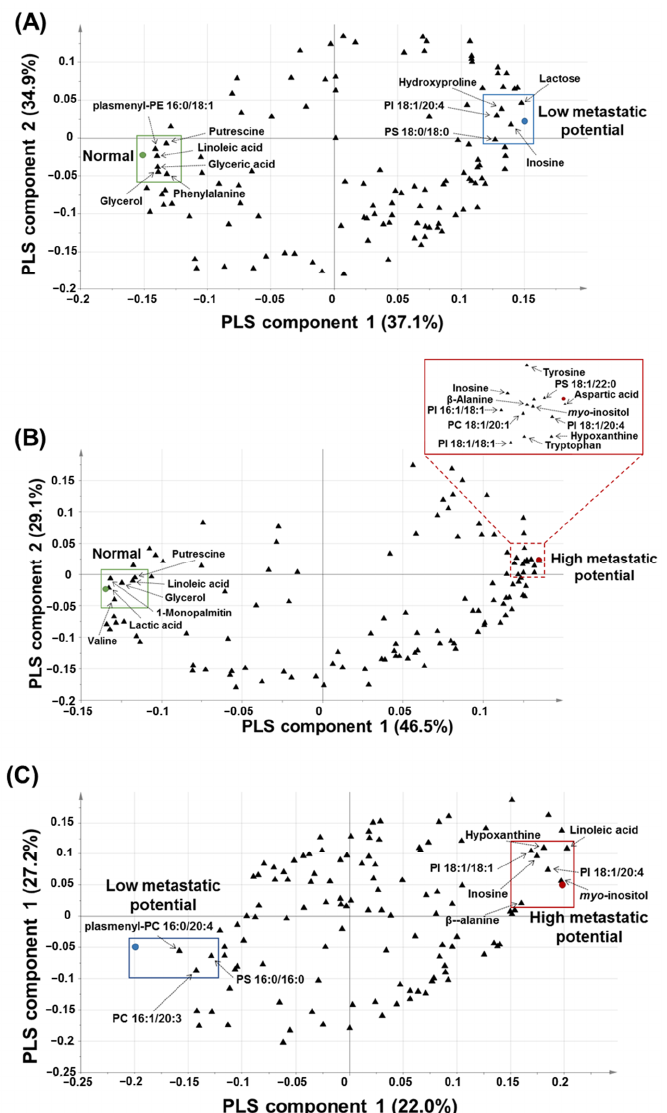
Figure 4. PLS-DA-derived loading plots: ( A ) PLS-DA-derived loading plot of normal versus low-metastatic potential cell lines; ( B ) PLS-DA-derived loading plot of normal versus high-metastatic potential cell lines; ( C ) PLS-DA-derived loading plot of low-metastatic potential versus high-metastatic potential cell lines. Overall, β-alanine, aspartic acid, glyceric acid, glycerol, hydroxyproline, hypoxan- thine, inosine, lactic acid, lactose, linoleic acid, 1-monopalmitin, myo -inositol, phenylala- nine, PC 18:1/20:1, PI 16:1/18:1, PC 16:1/20:3, PI 18:1/18:1, PI 18:1/20:4, plasmenyl-PE